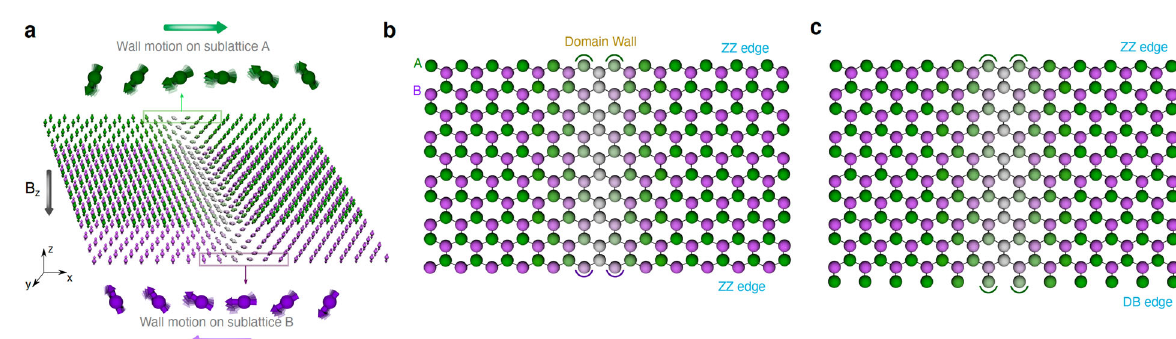
Fig. 5 Edge-induced domain wall dynamics in a 2D antiferromagnet under magnetic fi elds. a Schematic of the intended wall motion taking place in opposite directions at different sublattices (i.e., A or B) under an external fi eld B z . Only atoms at one sublattice (green or violet) are shown around each edge to facilitate the view. The rotation of the spins over time at sublattices A (green) and B (violet) are represented with the arrows changing systematically in the background. Only Mn atoms are shown. b , c Monolayer MnPS 3 terminated with both edges in zig-zag (ZZ) con fi guration, and with a combination of ZZ and dangling-bond (DB) arrangements, respectively. The domain wall is shown at the faint atoms in the middle of the layer.